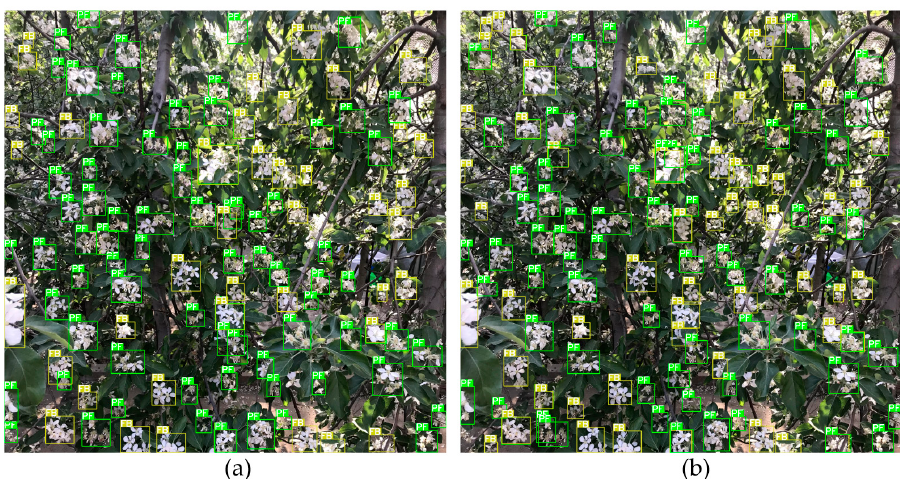
Figure 15. Comparison of the detection results of the model in this paper and the YOLOv5s model for apple flowers at the ‘Petal Fall’ stage. ( a ) Our model; ( b ) YOLOv5s.